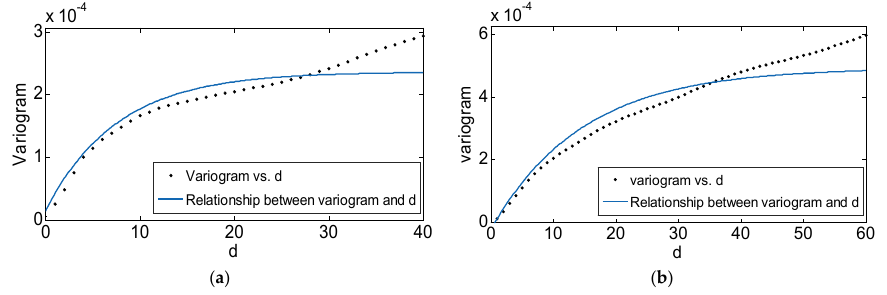
Figure 10. Relationship between the variogram and d for 500 m resolution. ( a ) The date of the MODIS image is 12 January 2016. ( b ) The date of the MODIS image is 25 January 2015. The black dots are the actual calculated variogram values and the blue solid lines are the curve fittings. Table 6. Results of the variogram curve fitting for 500 m resolution. The R-square denotes the coefficient of fitting determination. Curve Fitting Sum of Squares for Error R-Square Range 12 January 2016